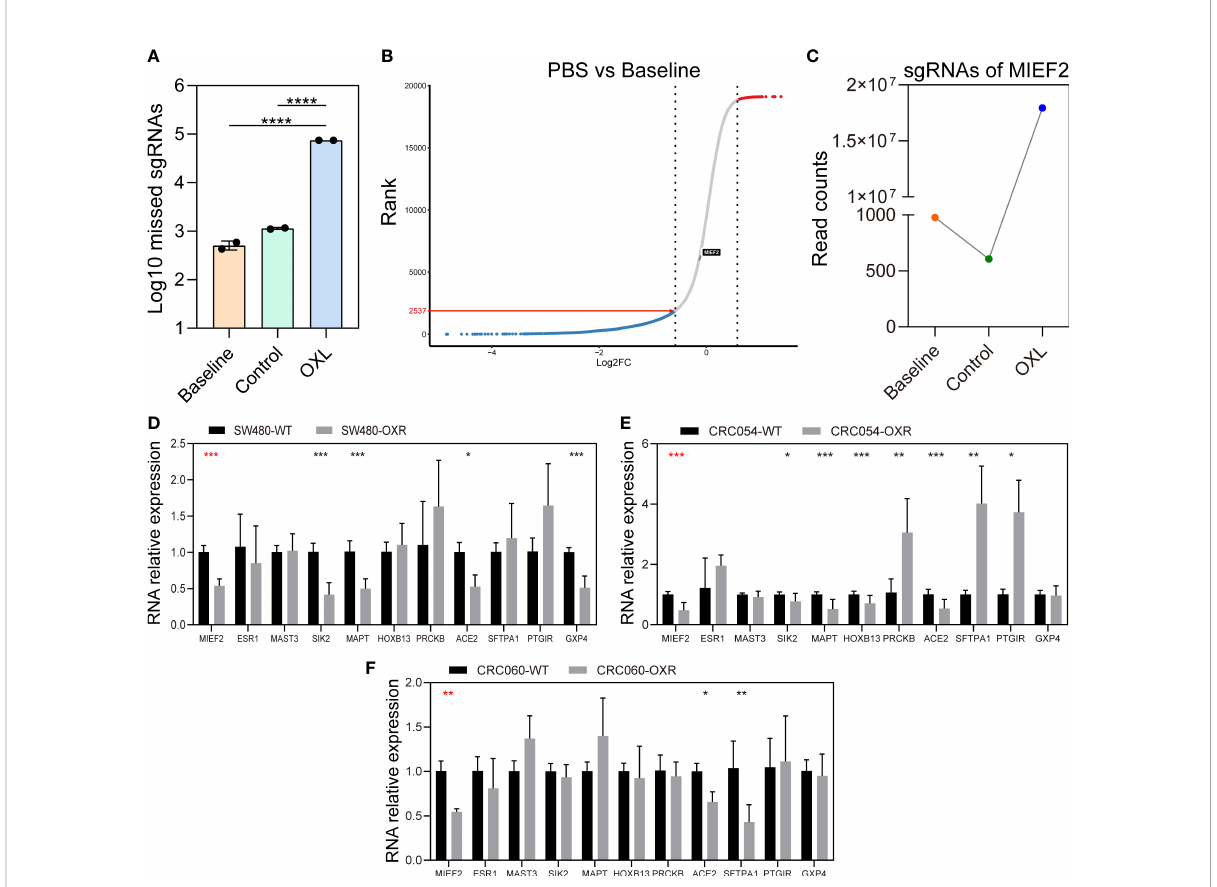
FIGURE 2 CRISPR knockout library screen identi fi es MIEF2 deletion as a key factor in OXL resistance. (A) Distribution of sgRNA in the baseline, PBS and OXL groups. (B) The sgRNA reads from the baseline and PBS groups were analyzed with MAGeCK and ranked genetically by robust ranking aggregation (RRA) score to check the effect of cell proliferation on library distribution. (C) MIEF2 was identi fi ed as the most important gene in the library screen. The sgRNA targeting MIEF2 was most enriched in the pool of OXL-treated mutant cells. (D – F) qPCR analysis for 11 genes in SW480, CRC054, CRC060 (OXL-sensitive), OXL-resistant cell SW480-OXR and OXL-resistant organoids CRC054-OXR and CRC060-OXR. Statistical analysis was performed using two-tailed unpaired t-test. * P <0.05, ** P <0.01, *** P <0.001, ****P < 0.0001 (mean ± SD, n = 3 biologically independent